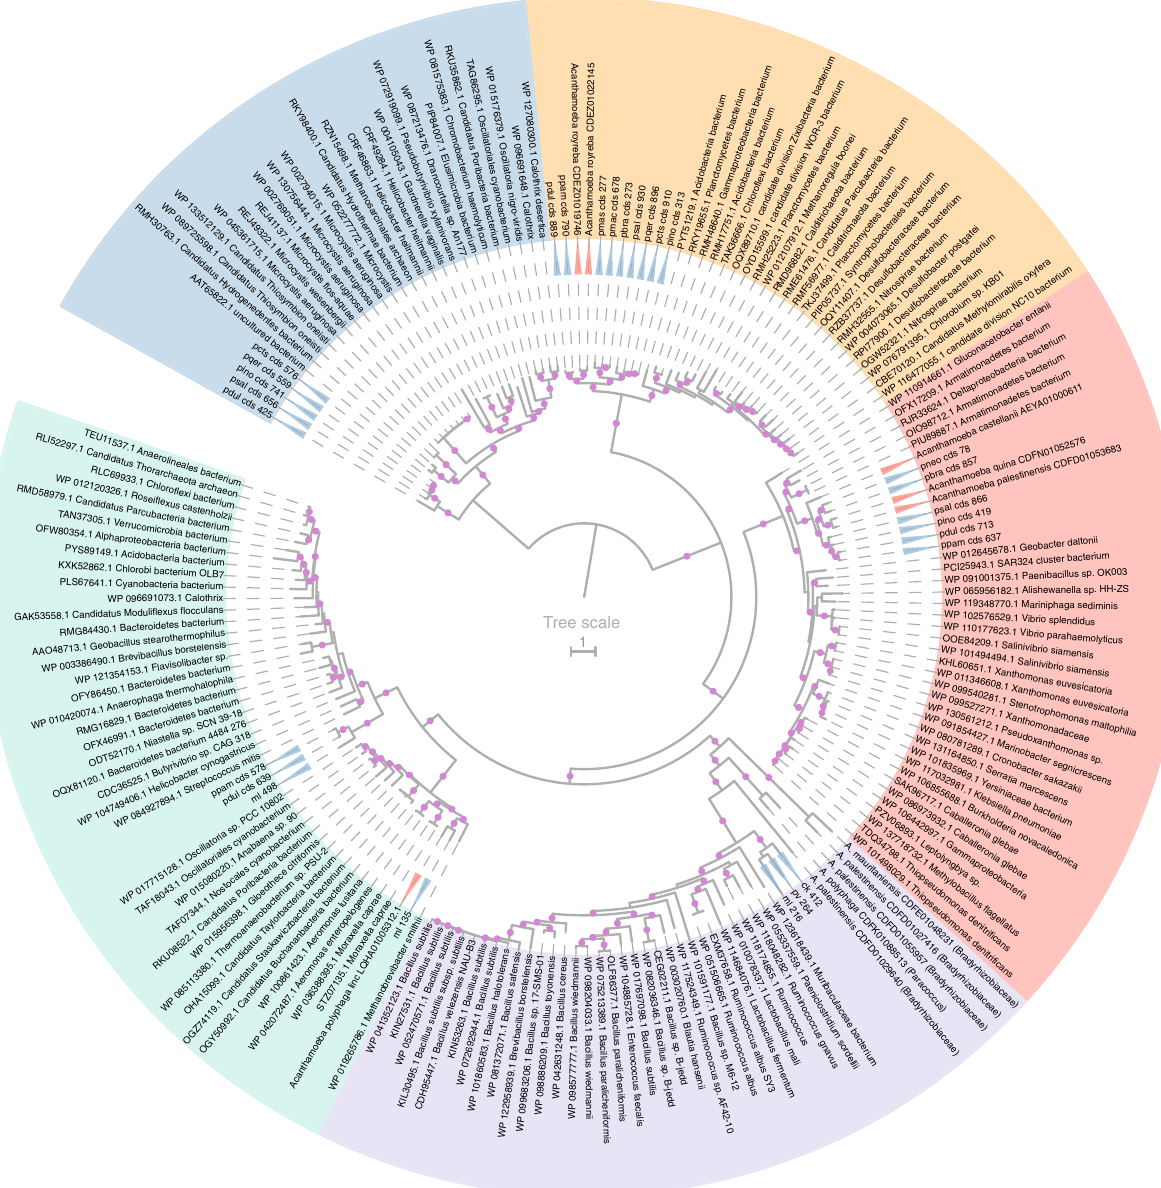
Fig. 5 Phylogenetic tree of the giant viruses MTases. Phylogenetic tree of the giant viruses ’ MTases along with prokaryotic and eukaryotic homologs. The blue triangles mark viral genes, the red ones eukaryotic genes and the unmarked genes are prokaryotic. The tree was computed using the LG + R6 model from a multiple alignment of 678 informative sites. Bootstrap values were computed using the UFBoot 84 method from IQtree 82 . All branches with support value > 80 are highlighted using purple circles. The GenBank accessions and taxonomic assignations extracted from GenBank entries are shown. The tree was rooted using the midpoint rooting method. The tree was split into fi ve subgroups highlighted using different colors (blue, orange, red, purple, and